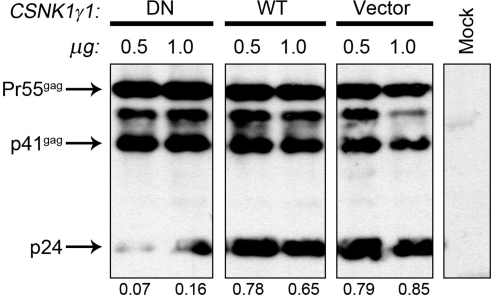
Effects of over-expression of wild type and dn-CSNK1G1 proteins on Gag processing.Cultures of 293T cells were transfected with 0.5 or 1.0 µg wild type CSNK1G1, dn-CSNK1G1, or parental vector (pcDNA 3.0) expression plasmids. One day later, cultures were transfected with pNL4-3-GFP proviral reporter plasmid and cell extracts were prepared one day later. Gag processing in virions associated with cells were examined in an immunoblot using a p24 monoclonal antibody. The ratio of p24 to the 55 kDa Gag precursor is indicated at the bottom of the immunoblot and it was and it was quantified by scanning the film and software analysis.